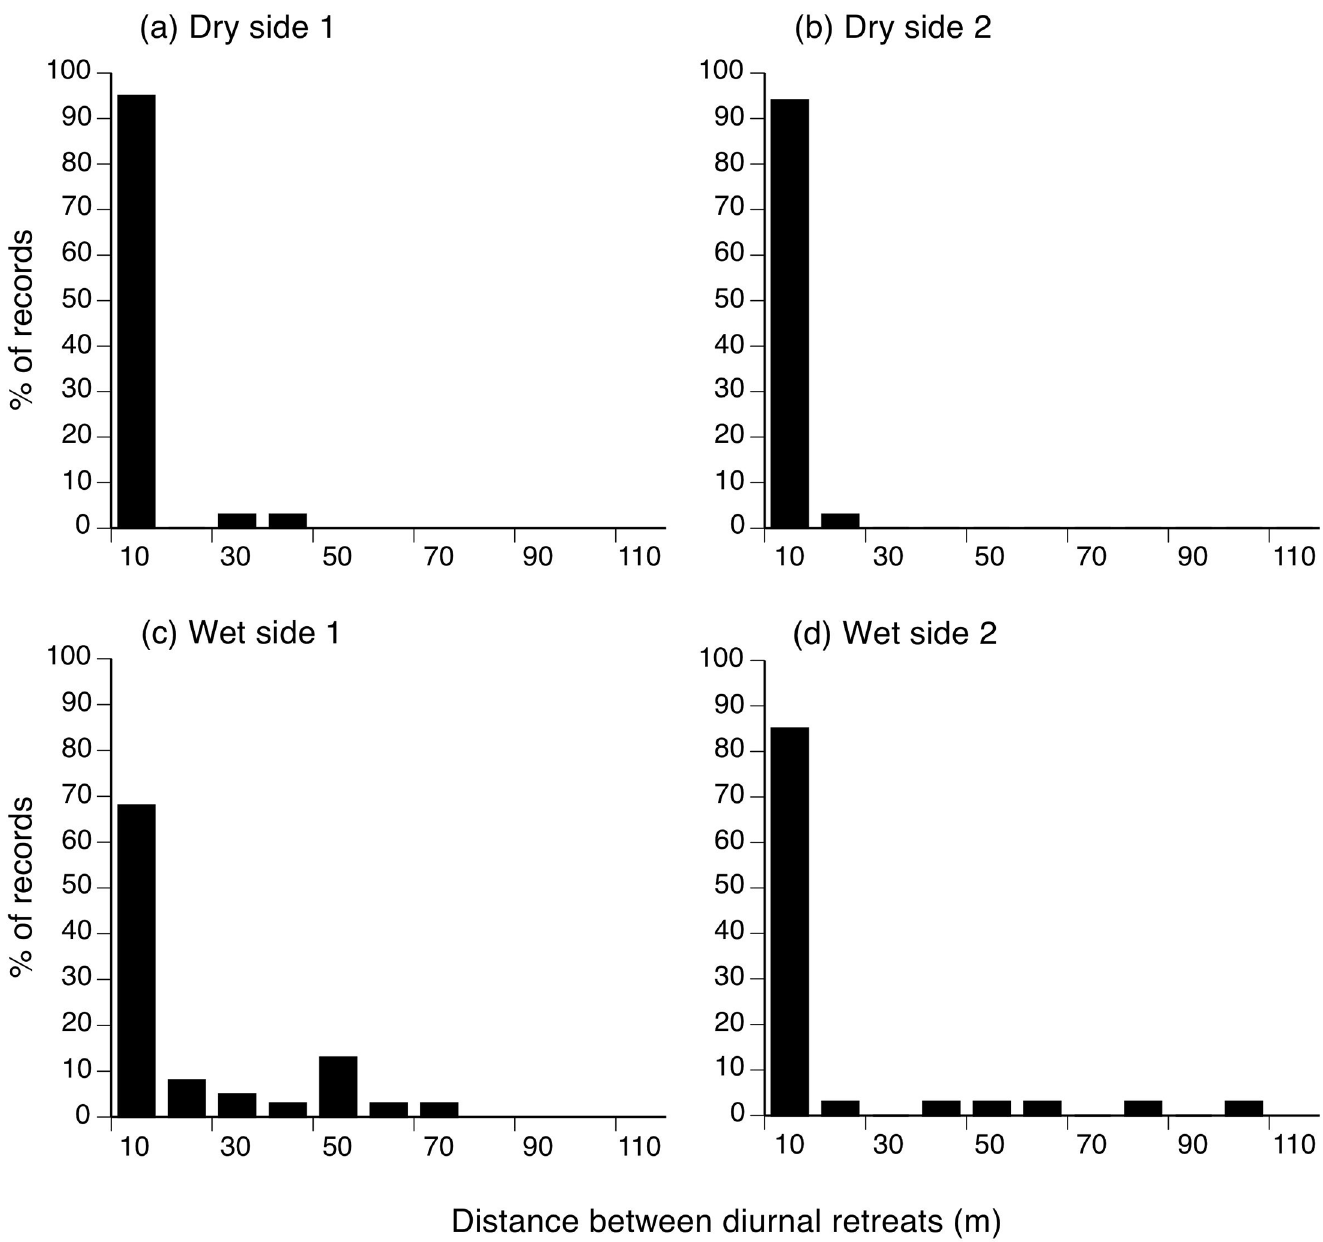
Fig 2. Distances moved by toads between diurnal retreats. Figure shows movement distances between successive diurnal shelters made by 40 radio- tracked cane toads on the island of Hawai ’ i. Data are shown for two sites on the leeward (dry) side of the island, and for two sites on the windward (wet) side.